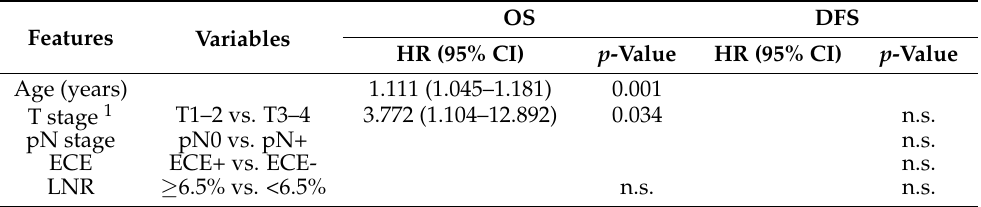
Table A3. Multivariate analysis of neck dissection factors associated with survival in patients with selective neck dissection level I–III *. n =